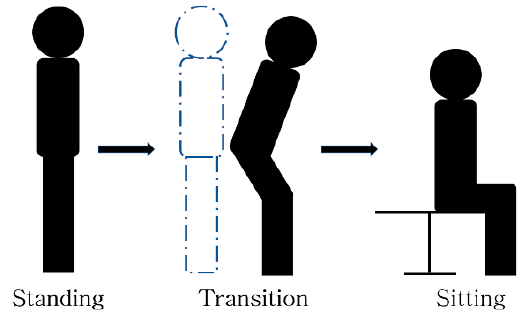
Figure 1. Example of transition activity.